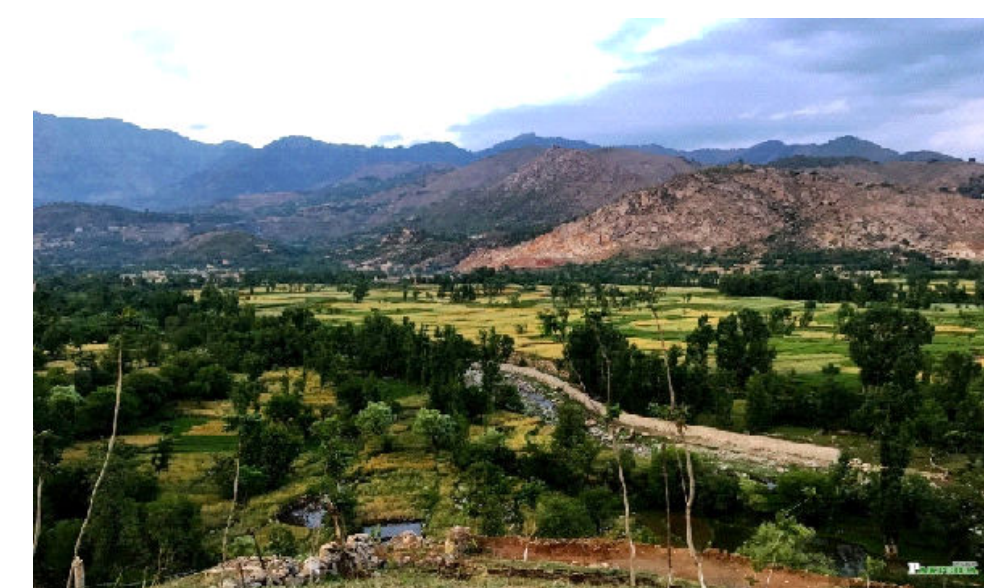
Figure 2. A panoramic view of Bajaur area with lush green fields and water courses